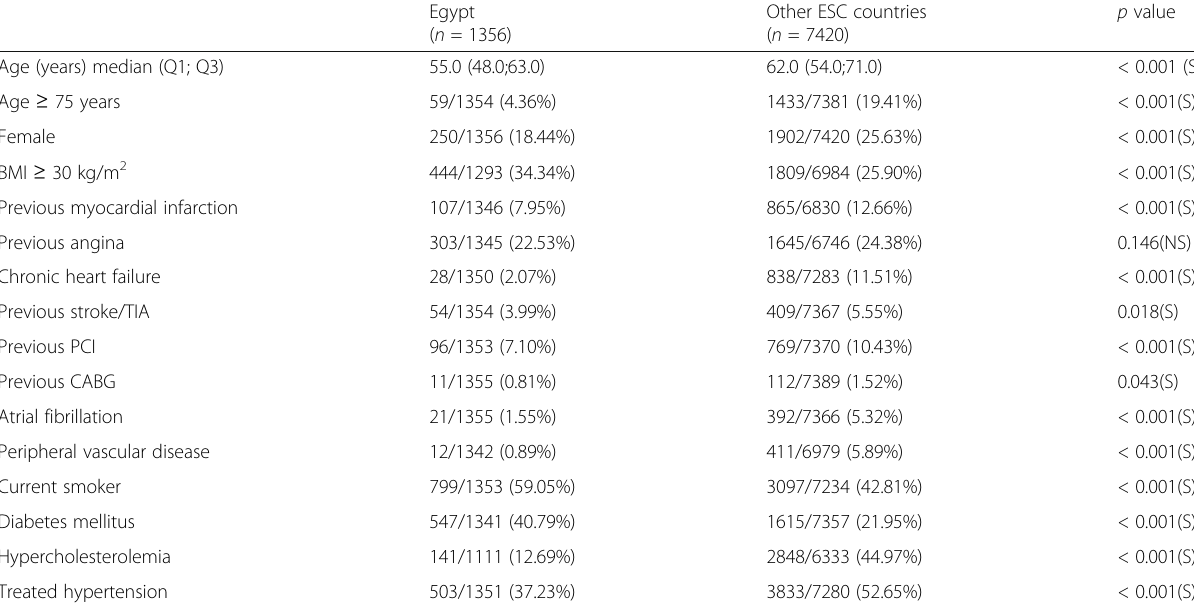
Table 1 Patients baseline clinical characteristics; Egypt vs. other ESC countries